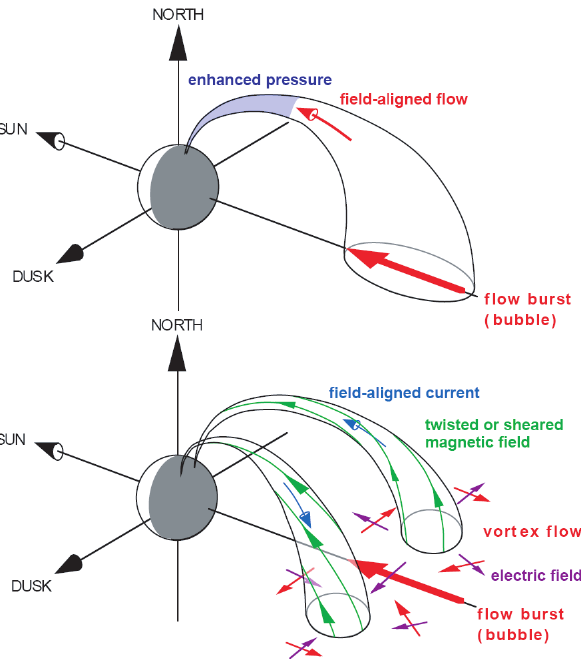
Fig. 40. Bubble properties in the equatorial plane at time t=15 (in normalized units) after its formation, including (from top to bot- tom): the entropy distribution, diversion of the parallel current den- sity integrated over Z, and flow speed. (From Birn et al.,